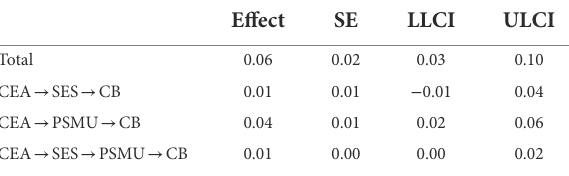
TABLE 2 Indirect effect of self-esteem and problematic social media